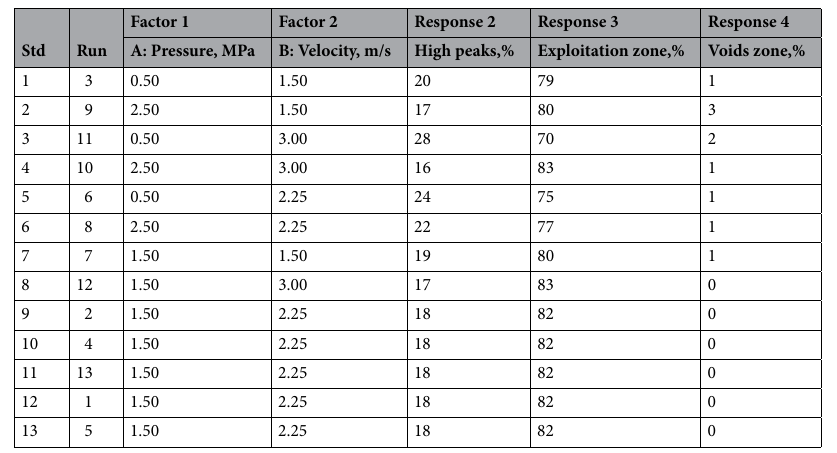
Table 8. Experimental CCD showing Abbott Firestone zones of 0.16C hot-rolled steel.